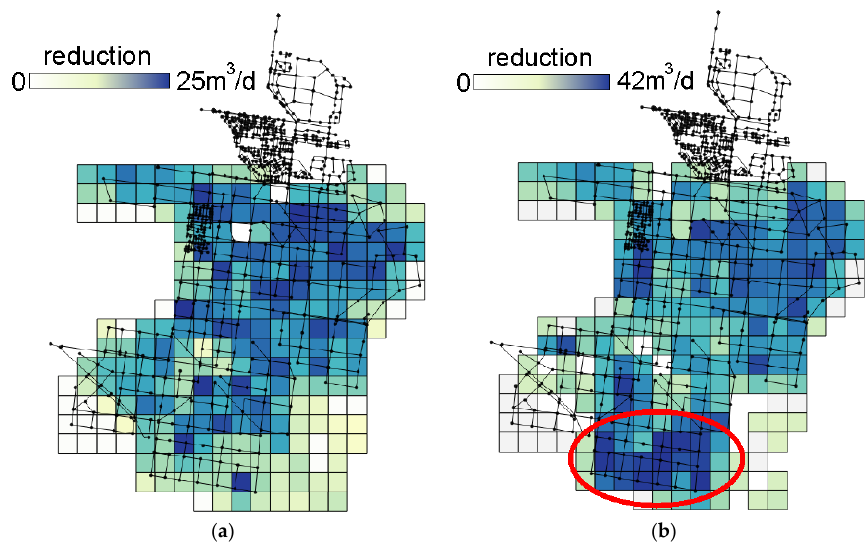
Figure 5. Spatially-distributed demand reductions for the scenarios reduced irrigation (RI) ( a ); and water efficiency (WE) ( b ) (adapted from [18] with permission from ASCE).